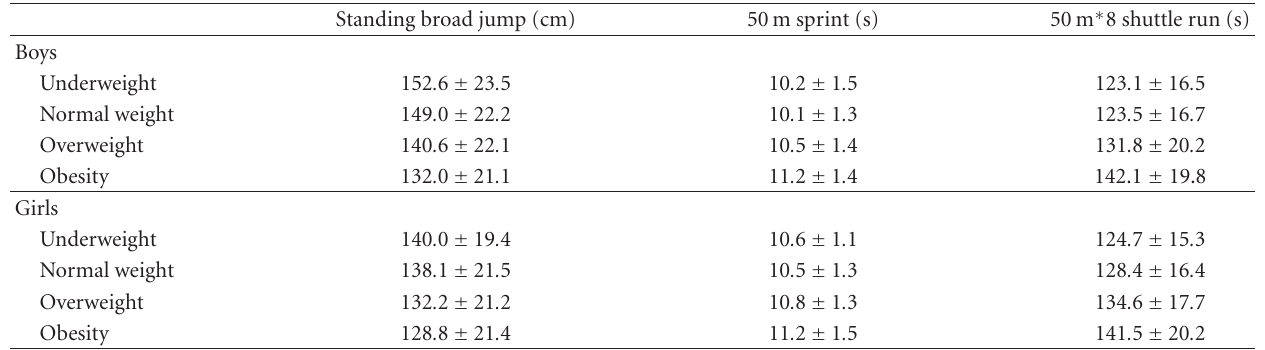
Table 3: Mean in physical fitness test results for underweight, normal weight, overweight, and obesity group by gender (Mean ± SD).